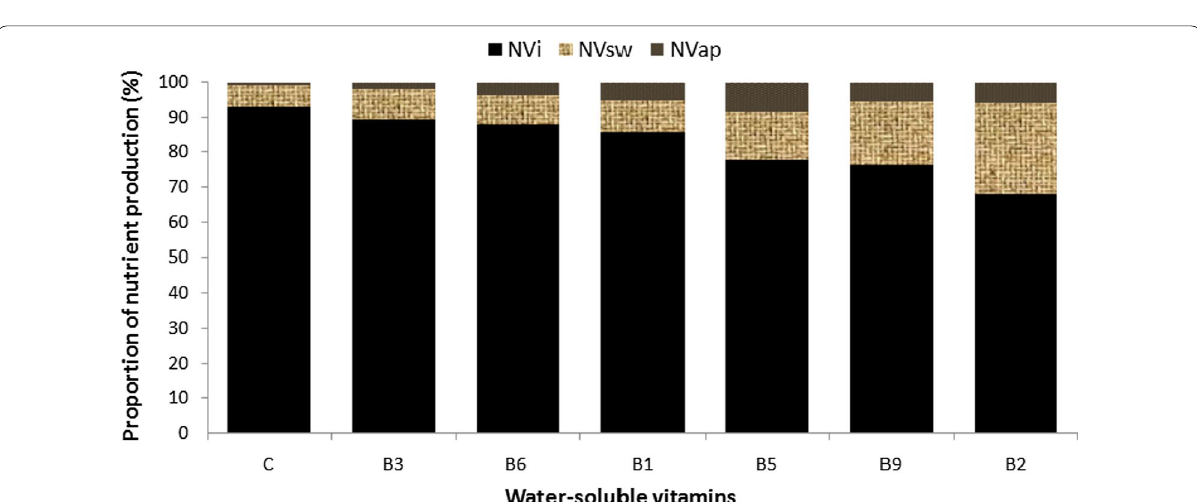
Fig. 4 Proportion of water-soluble vitamins in national crop production attributed to pollinator-independent crops, self- or wind pollination and animal pollination. C